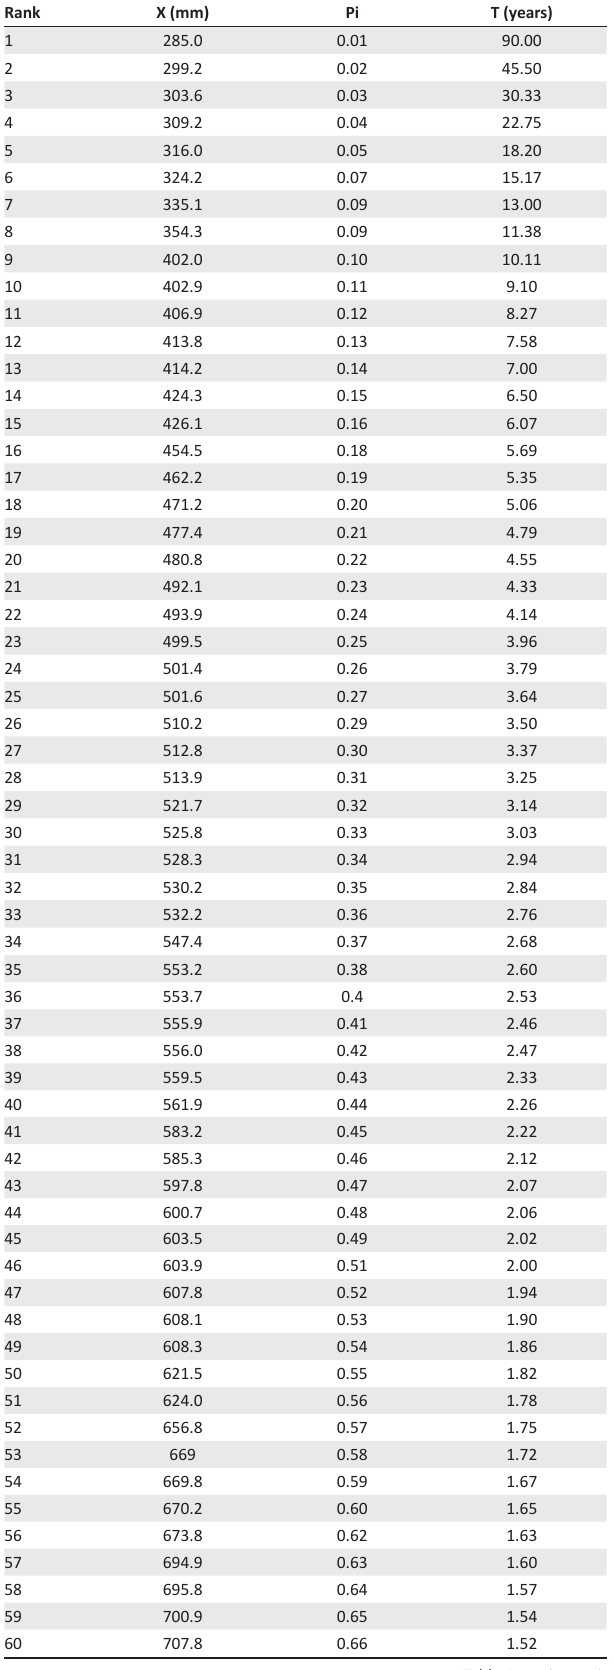
TABLE 4: Rainfall totals, plotting positions and return periods of maize prone to agricultural drought in the growing period of December to February in the rainfall zone X3B.